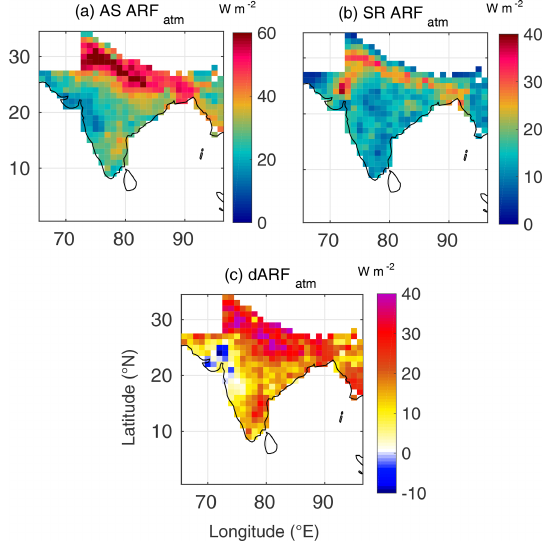
Figure 7. Spatial variation of (a) AS ARF atm (atmospheric forc- ing estimated using AS AOD and AS SSA), (b) SR ARF atm (at- mospheric forcing estimated using SR AOD and SR SSA) and (c) dARF atm for May